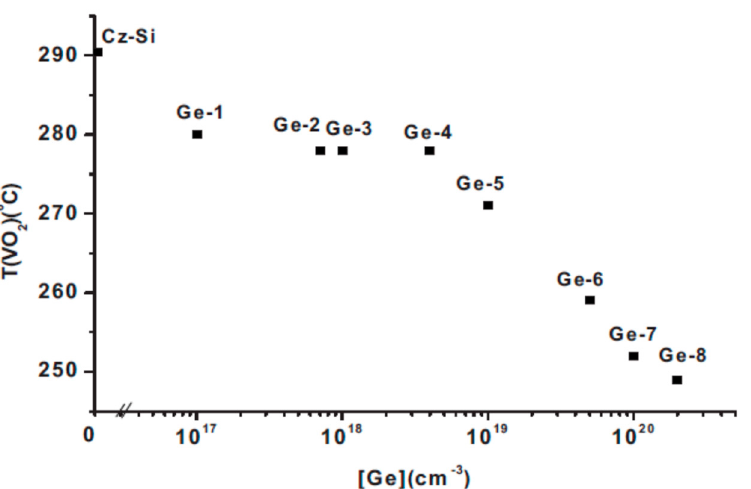
Figure 8. Formation temperature of VO 2 defects as a function of Ge dopant concentration. Repro- duced with permission from [128]. American Institute of Physics, 2010.